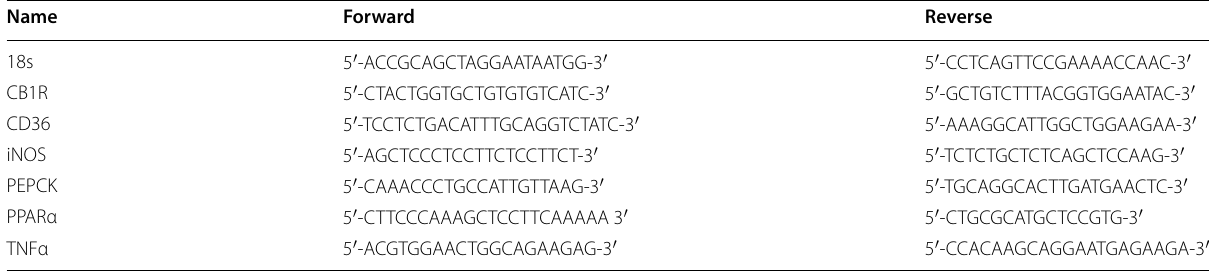
Table 2 Primer sequences for qRT‑PCR